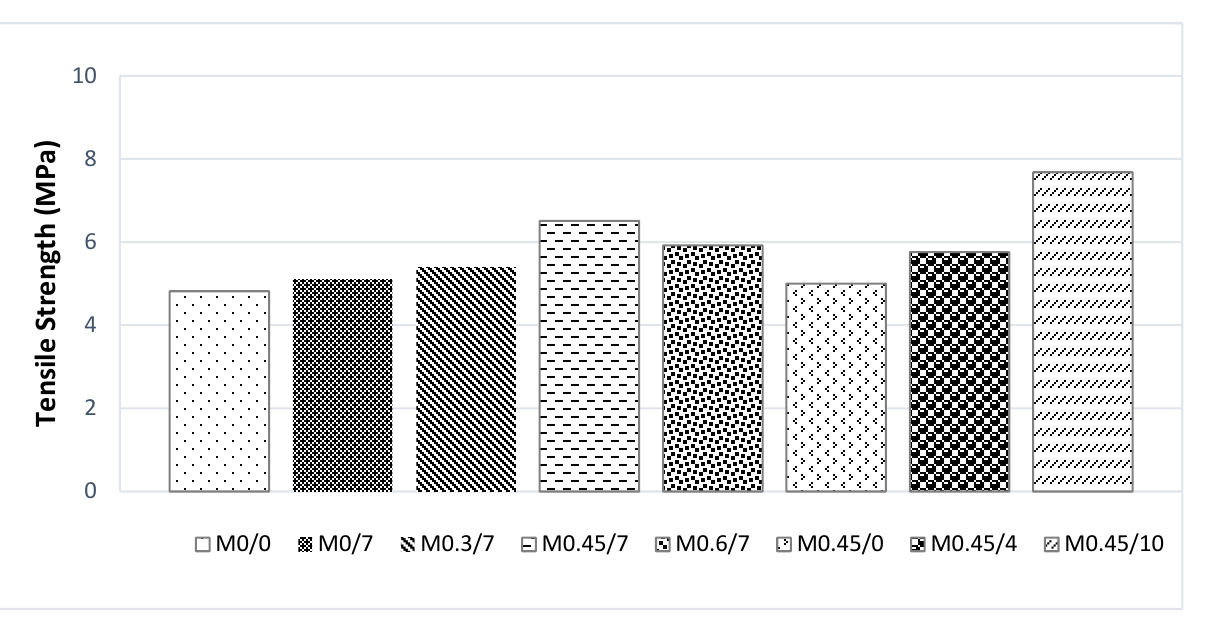
Figure 3. Tensile strength for all concrete specimens under ambient conditions.